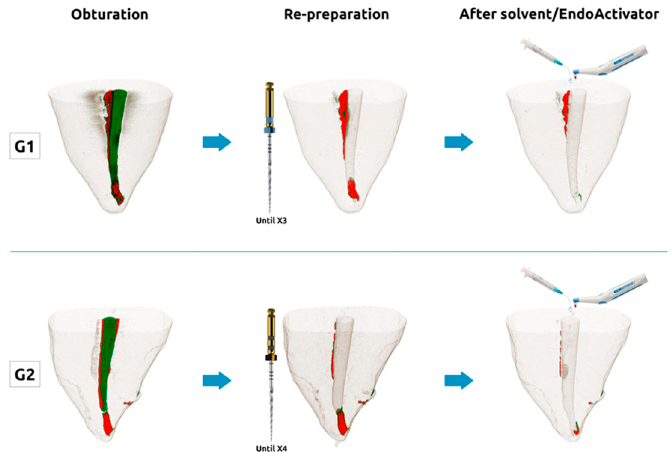
Figure 1. Micro-computed tomographic (Micro-CT) images of representative specimens subjected to the different procedures (obturation with X2 gutta-percha cone and AH Plus sealer (G1 and G2); re-preparation until X3 (G1) and X4 (G2); after solvent / EndoActivator (G1 and G2). Green: gutta-percha; red: sealer.